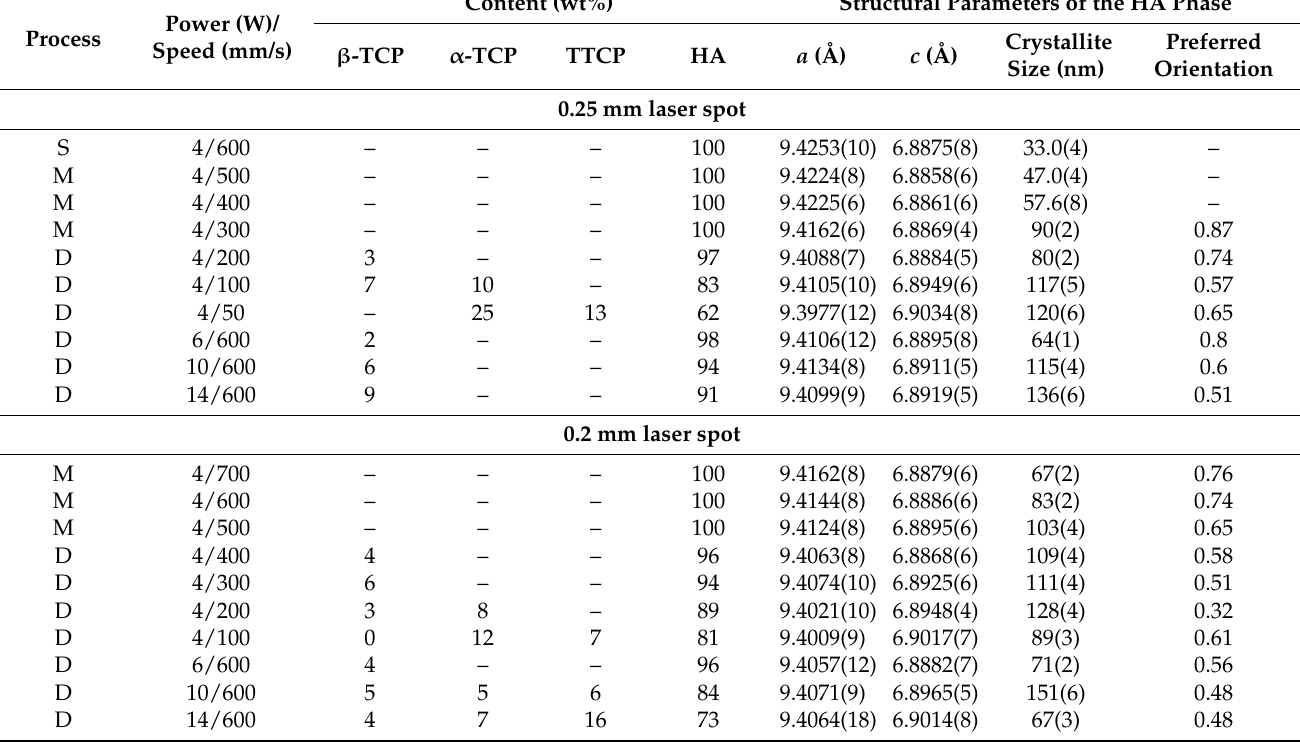
Table 4. Phase composition and lattice parameters of the HA phase treated with laser spots of 0.2 and 0.25 mm in size at different scanning speeds and laser power